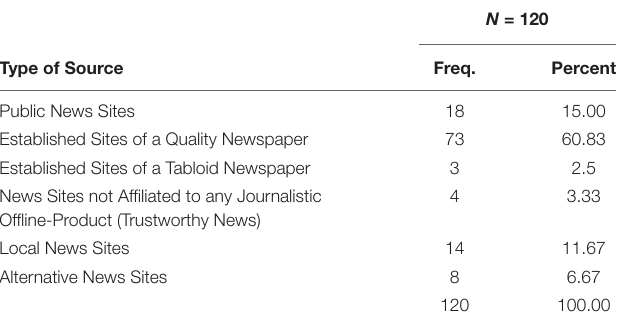
TABLE 5 | Average number of scientific and non-scientific sources per task 1